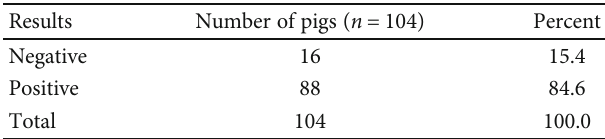
Figure 1: Map of Nyagatare district and the study area. Table 1: Overall prevalence of swine gastrointestinal parasites in Nyagatare